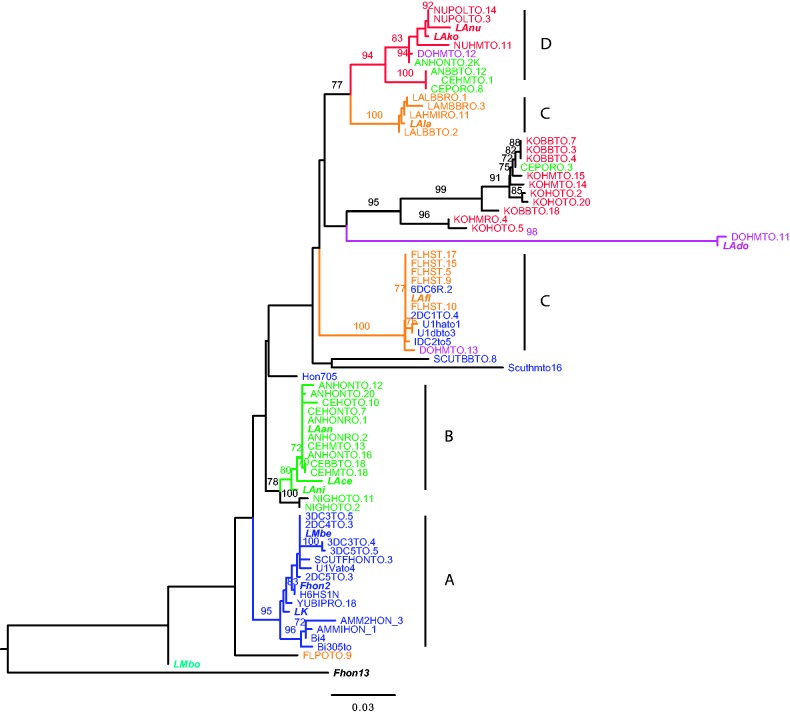
Coinfections inferred from PCR screening of multiple isolates. The phylogeny was inferred from a fragment of the recG gene for multiple L. kunkeei strains. The colors in the external nodes represent sequences obtained from hosts that belong to the described microclusters: A (blue), B (green), C (orange), D (red), and LAdo (purple). The same colors in the branches represent the microcluster to which the last well-supported ancestor of each of the sequences coming from the genomic data belongs, and all its descendants. The phylogeny was inferred with the maximum-likelihood method.